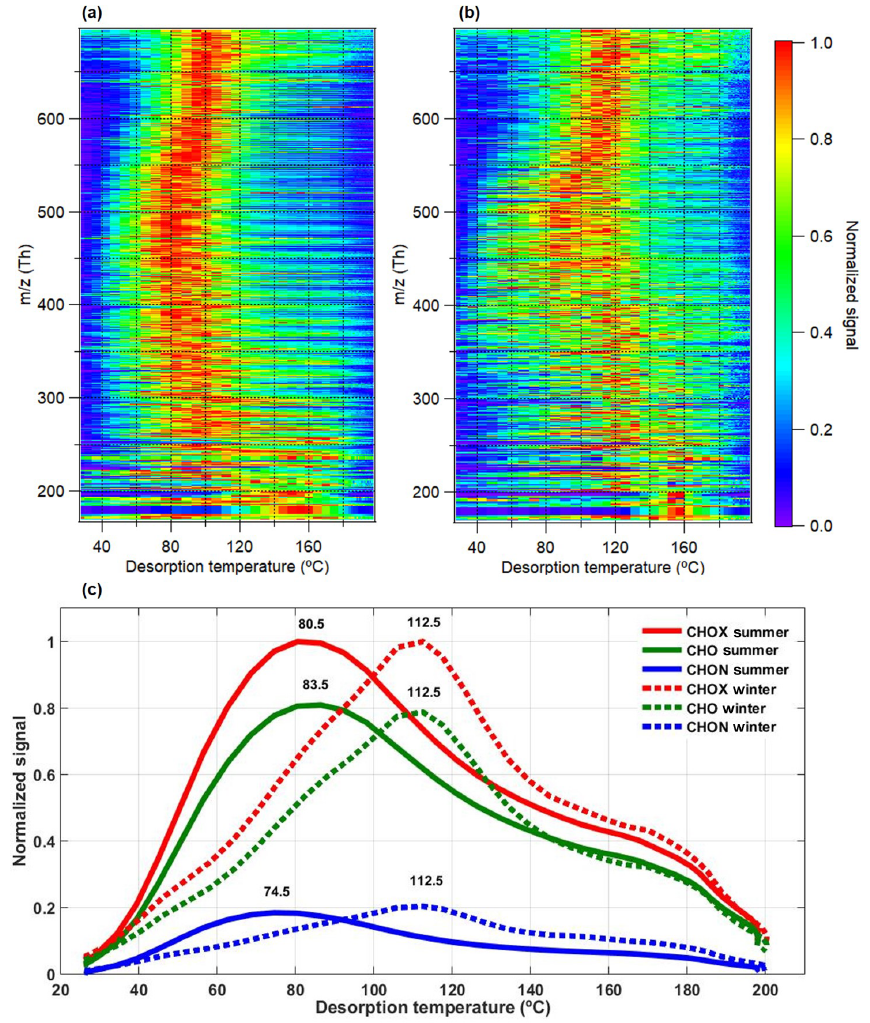
Figure 4. Comparison of campaign average high-resolution two-dimensional (2-D) thermograms of CHOX compounds for the summer (a) and winter (b) periods vs. m/z (includes mass of I − ion; m/z 126.9050Th) and the sum thermograms of CHOX, CHO, and CHON compounds (c) . The 2-D thermograms and sum thermograms were normalized to their maximum